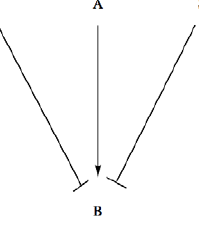
Figure 6. Genetic regulatory network for the production of protein B with one activator A and two repressors R and S .